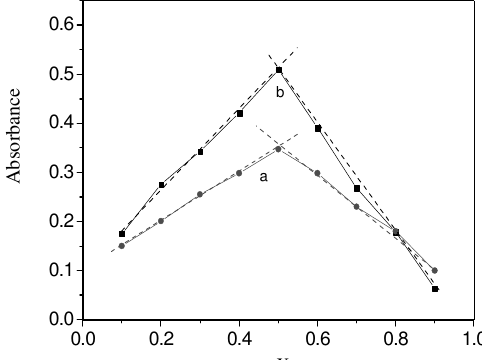
Figure 6 . Jobs continuous variation plot for the complex ion associate of bismuth(III) with the ion pairing reagent Tz + .Cl